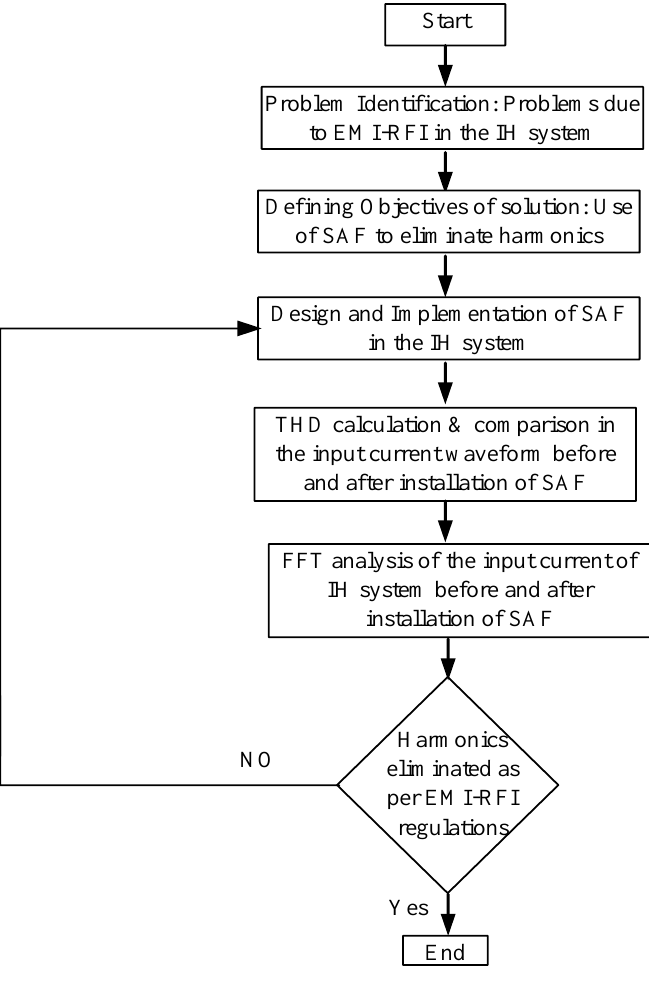
Figure 1. Research methodology of the proposed